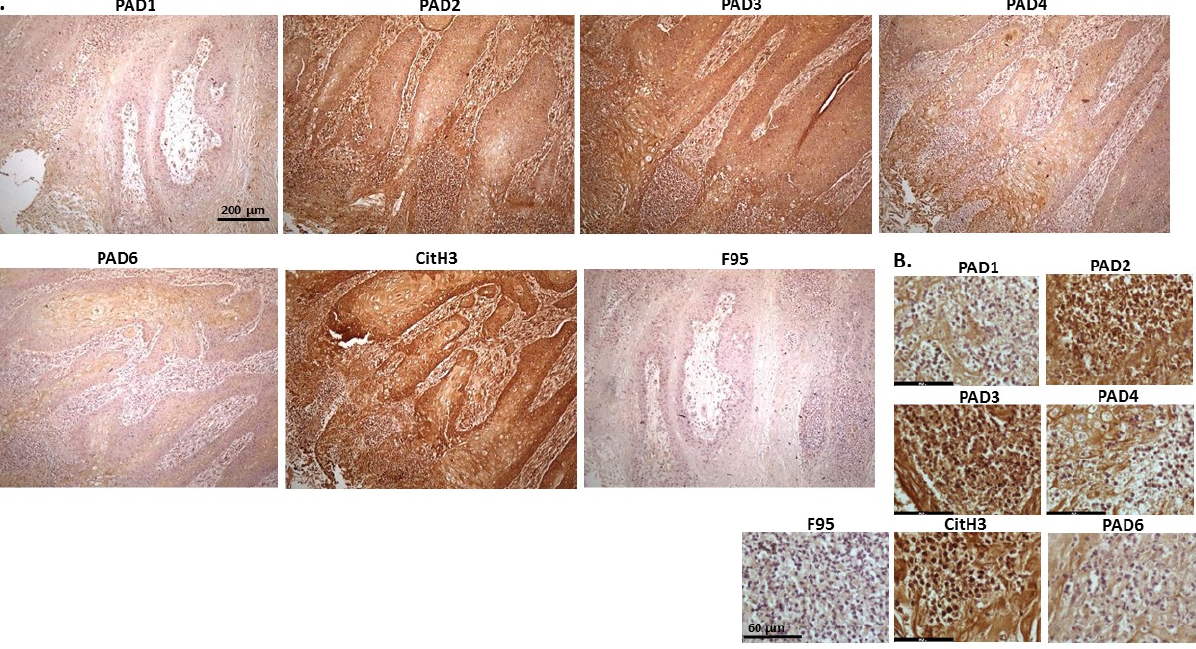
Figure 20. Horse, squamous penile cell carcinoma, papilloma. Scale bar represents 200 μ m for all images. ( A ) Overview images for PAD1, 2, 3, 4, 6, CitH3, and F95 stainings of serial tissue sections; scale bar represents 200 μ m for all images; 10× objective. ( B ) Higher magnification shown for each staining from the images in ( A ); scale bar represents 60 μ m for all images; 40× objective.